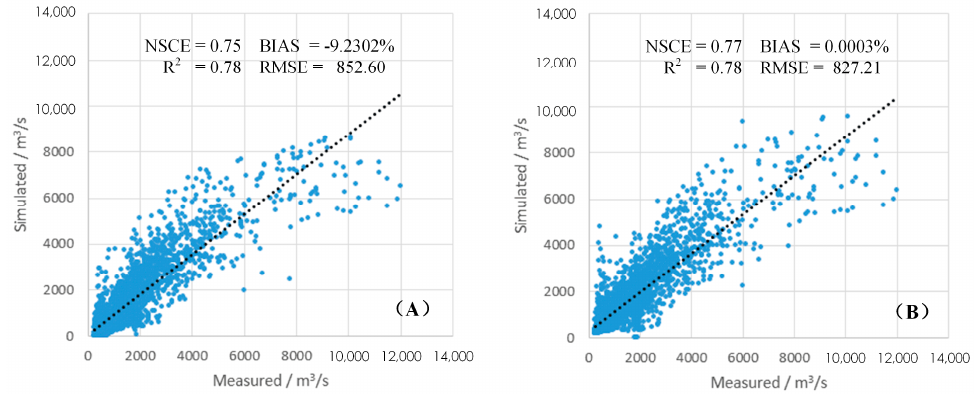
Figure 4. Scatter plots between measured and simulated basin outlet streamflow of CREST ( A )